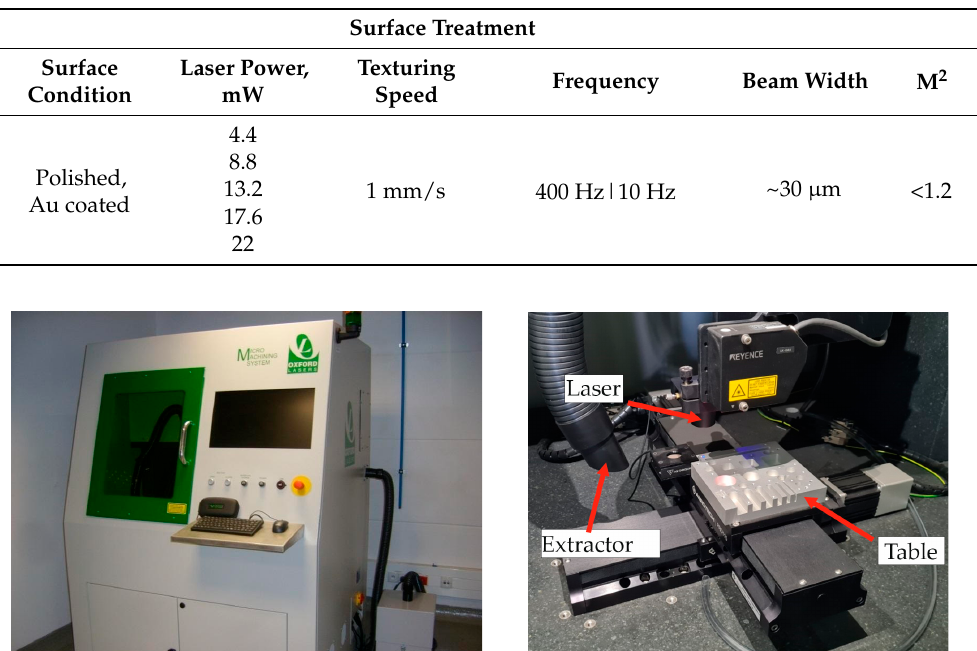
Table 2. Laser texturing parameters.